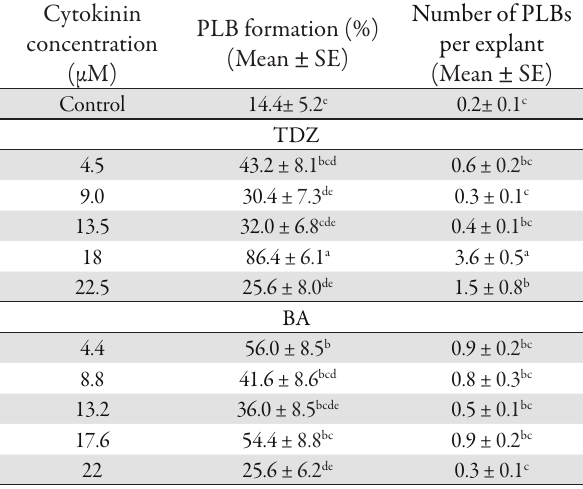
Tab. 1. Effects of TDZ and BA on the induction of PLBs from protocorms of dwarf Dendrobium after 9 weeks of culture Cytokinin